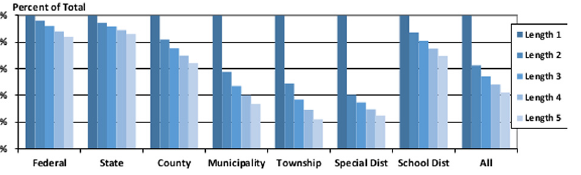
Fig 7. Proportion of Governments with Consecutive Years of Data. This figure shows how the requirement of consecutive observations will limit the data that is available, and disaggregates the impacts by government